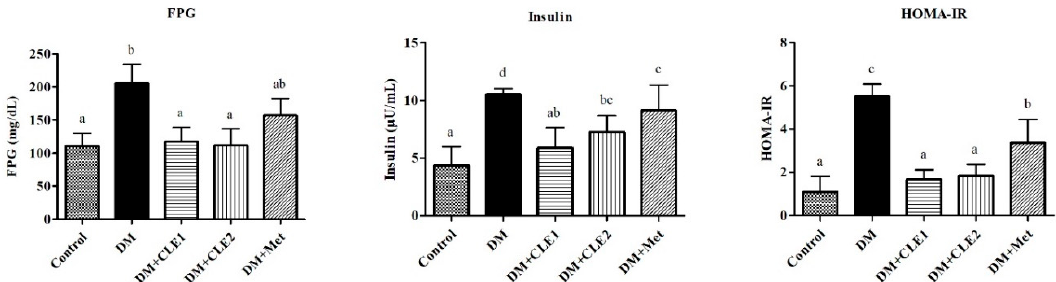
Figure 2. The value of fasting plasma glucose (FPG), insulin, and HOMA-IR in diabetic mice after treatment for 6 weeks. Data are shown as mean ± SD ( n = 5). The values with different letters (a–d) represent significant difference ( p < 0.05) as analyzed by a Duncan’s multiple range test. DM, diabetes; DM+CLE1, diabetes and 600 mg/kg of C. lentillifera ; DM+CLE2, diabetes and 1000 mg/kg of C. lentillifera ; DM+Met, diabetes and 200 mg/kg of metformin; HOMA-IR, homeostatic model assessment of insulin resistance.